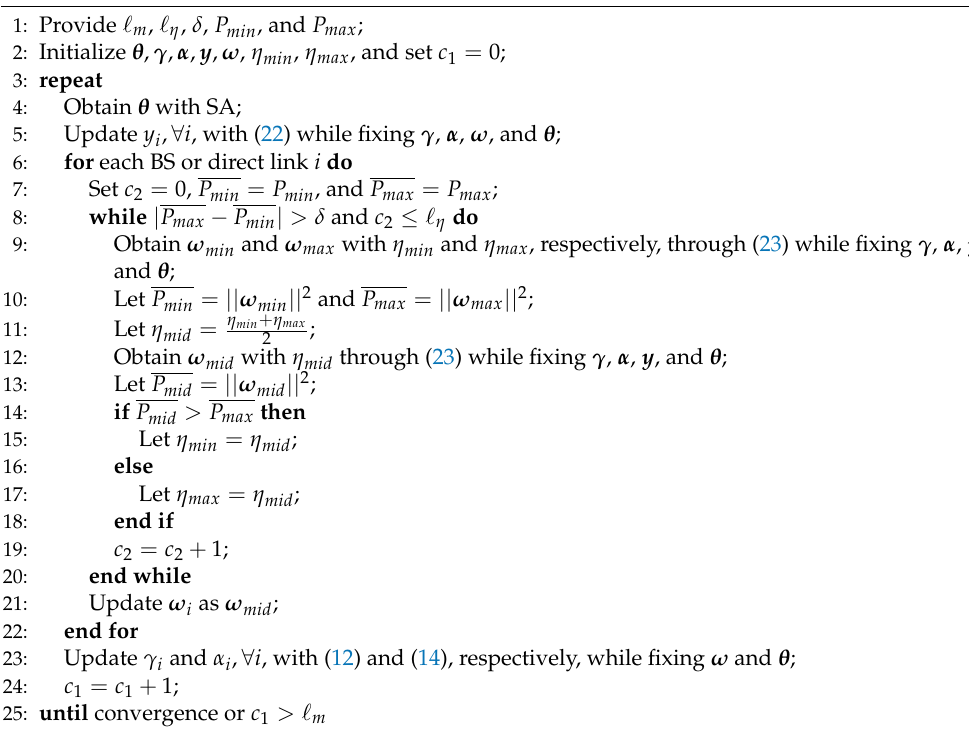
Algorithm 1 EA-aided FP